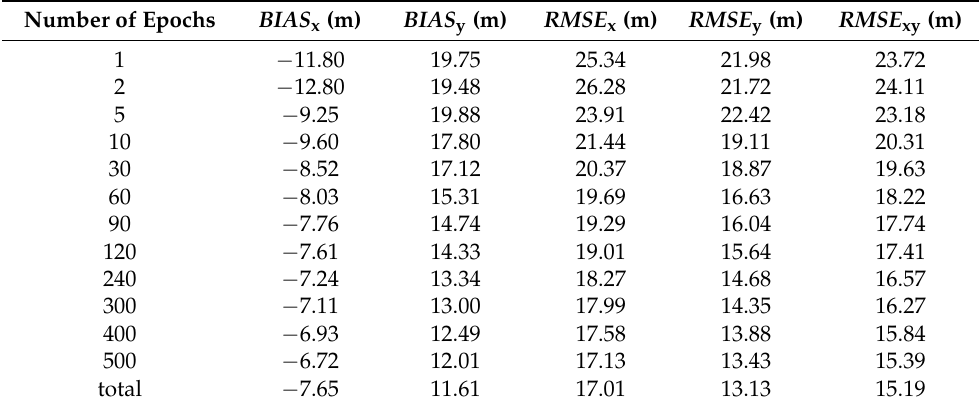
Table 3. Single-point positioning accuracy error analysis of multi-epoch data.